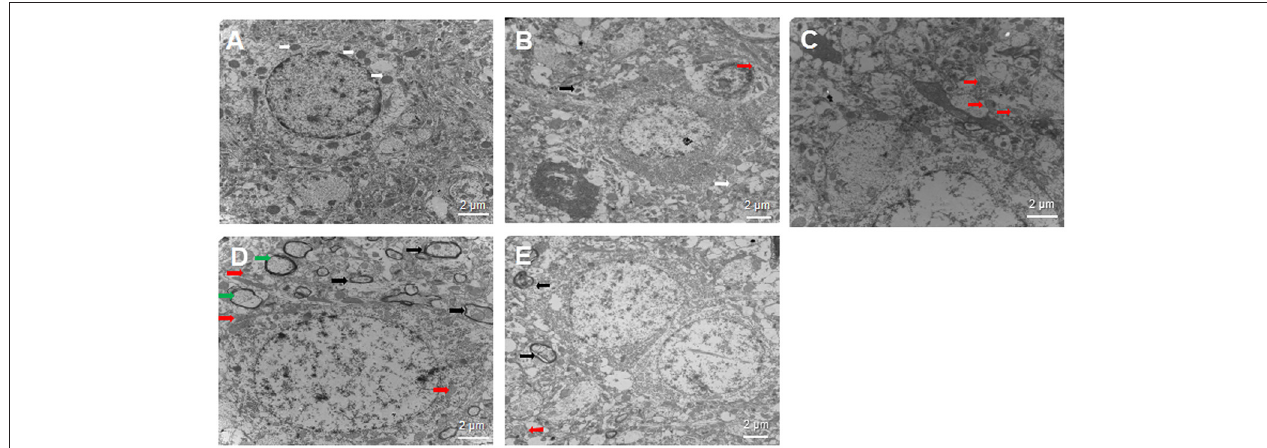
FIGURE 5 | Effect of SA on neural cell ultrastructure after ICH. Autophagy is activated following ICH. Brain samples were isolated from rats at 3 days after sham or ICH surgery and analyzed by transmission electron microscopy. Representative sections are shown from the (A) sham, (B) ICH, (C) 3-MA, (D) SA, and (E) SA + 3-MA groups. Magnification, 10000 × (A, C, D) , 8000 × (B) or 7000 × (E) . White arrows indicate healthy mitochondria; red arrows, damaged mitochondria; black arrows, autophagosome; and green arrows, autolysosomes. Scale bars, 2 µ m. ICH, intracerebral